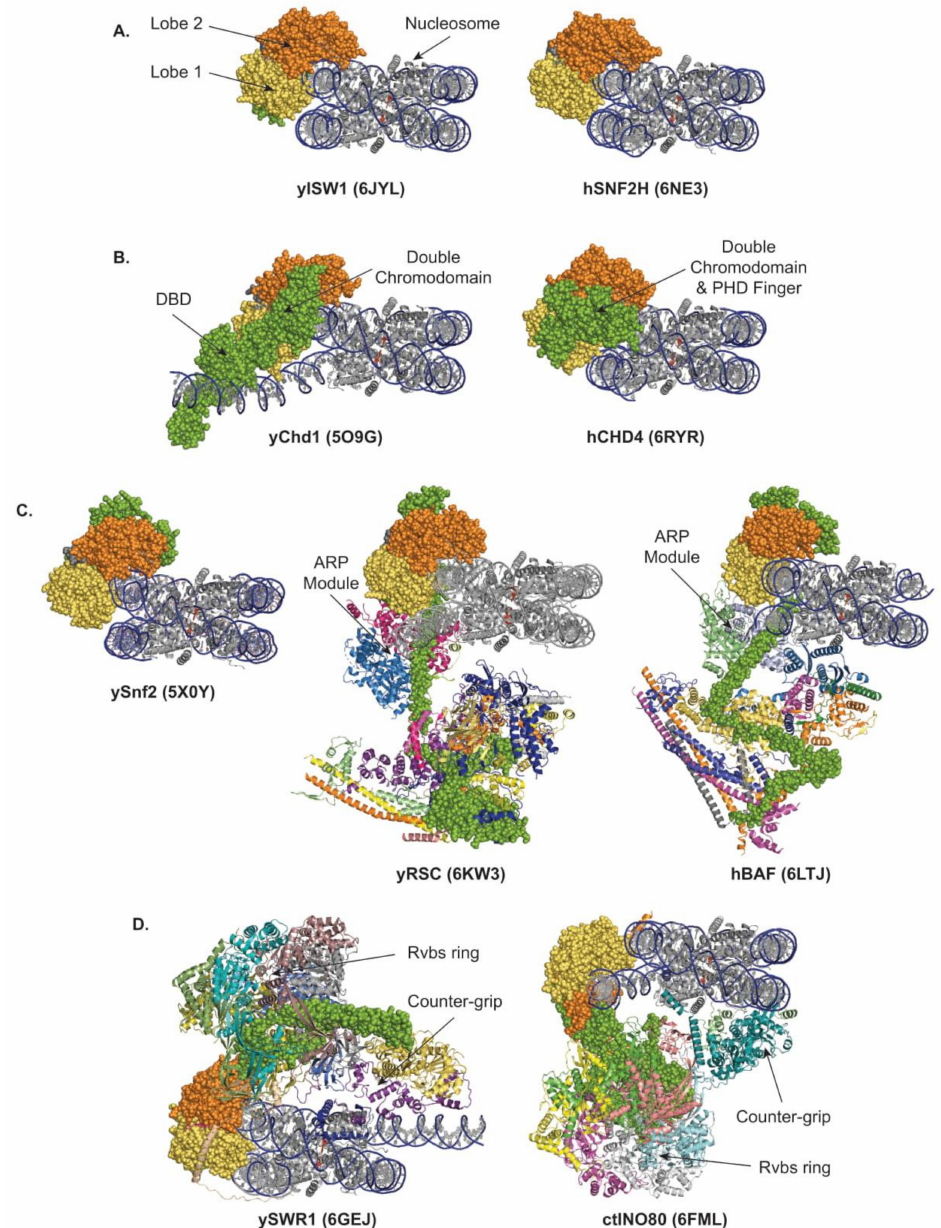
Figure 3. Cryo-EM structures of nucleosome-bound remodelers. Remodelers from the ( A ) ISWI subfamily are yeast Isw1 (6JYL), and human SNF2H (6NE3); ( B ) CHD subfamily are yeast Chd1 (5O9G) and human CHD4 (6RYR); ( C ) SWI/SNF subfamily are yeast Snf2 (5X0Y), yeast RSC (6KW3), and human BAF (6LTJ); and ( D ) INO80 subfamily are yeast Swr1 (6GEJ) and C. thermophilum Ino80 (6FML) bound to a nucleosome are depicted in the same orientation resulting from a structural alignment of their respective histone octamers before being separated into panels. Corresponding features are depicted with the same color codes. The ATPase subunits are depicted in spheres, with lobe 1 in yellow, lobe 2 in orange (as in Figure 2), and the rest of the subunit in green. The other subunits, if any, are depicted as colored cartoons. The dyad base-pair of each nucleosome is depicted in red. A few remarkable features have been named and indicated by arrows. All the remodelers from the various subfamilies engage the nucleosome in a similar or an inverted